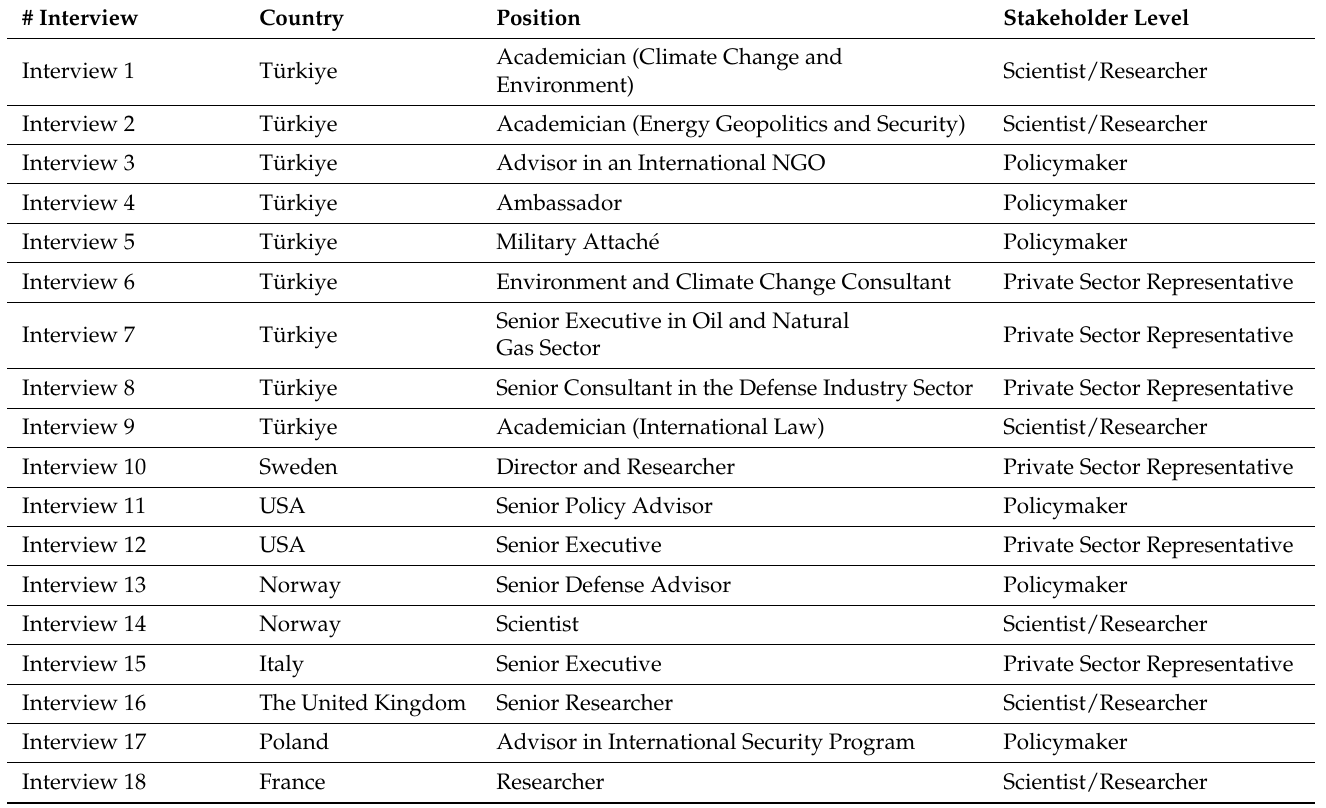
Table 1. Semi-structured in-depth interview